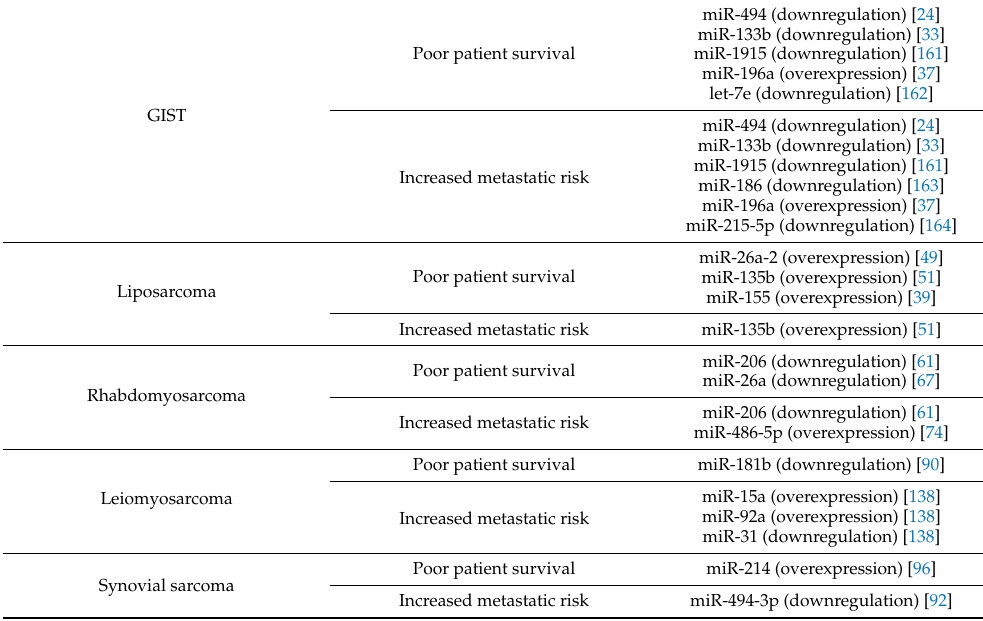
Table 2. miRNAs that prognosticate for poor survival and metastasis in soft tissue sarcoma.